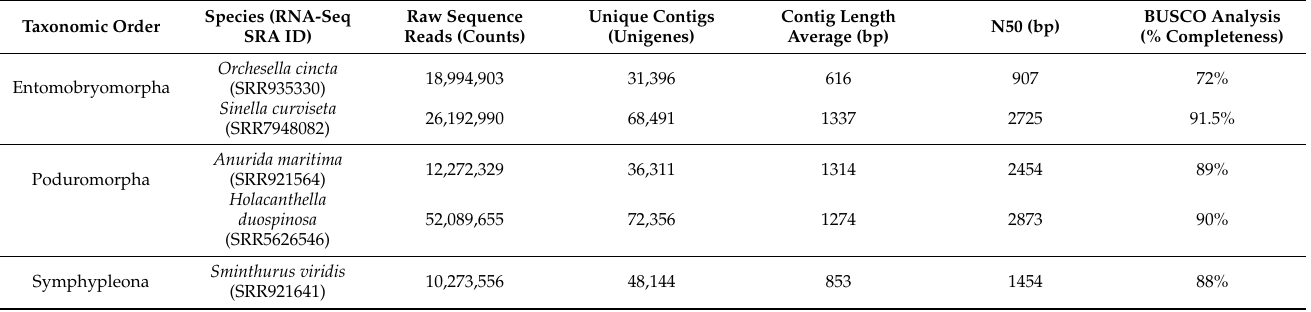
Table 1. Basic information and statistics of the transcriptome assemblies from five